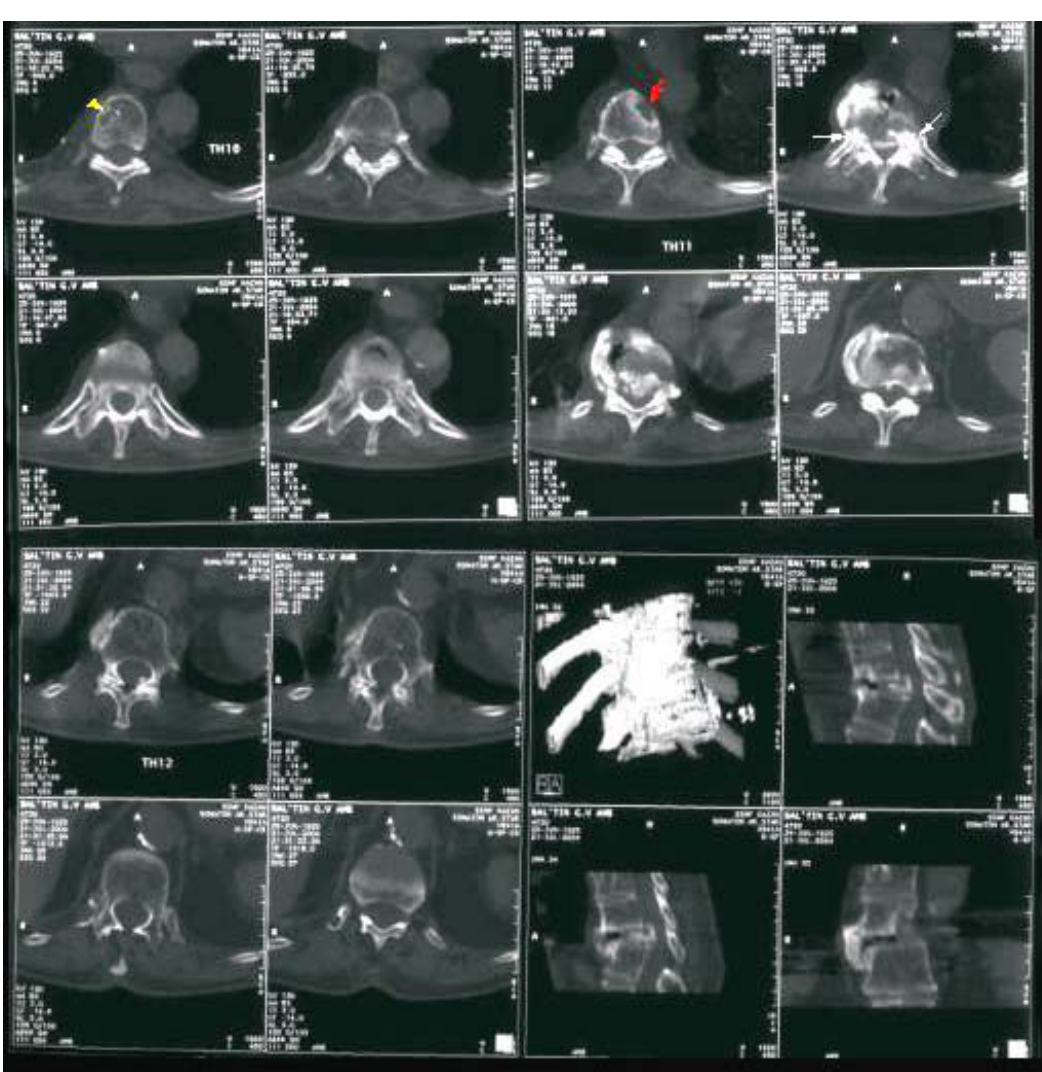
FIGURE 2 . MRIs of patient with backbone metastases (after treatment with bacteria). There is progressive spinal deformity: collapse of the anterior part of Th.XI. vertebral body is complete with more prominent wedge-shaped deformity. Posterior sclerotic bony elements shifting towards the canal cause significant stenosis (at least 50% in AP direction). Remarkable osteophytic appositions have developed on the right lateral aspect of Th.X.–XI. intervertebral spaces. There is marked progression of sclerotic degenerative changes in the facet joints as well. There is sclerosis in the vertebral arches instead of the formerly observed lytic areas. No evidence of soft-tissue mass. The lytic area affecting the left anterior aspect of Th.X. vertebral body became demarcated by irregular slerotic margin. The lesion in the Th.IX. vertebral body is unchanged. Compression fracture of Th.XI. vertebral body was probably caused by lytic bone pathology, which seemed to affect Th.X. vertebral body as well. From the available data, the nature and dignity of this process cannot be determined with confidence; both malignant neoplasia (metastasis) and benign tumors/tumor-like lesions may be taken into consideration. The follow-up, however, reveals progression only in the secondary deformity and the accompanying degenerative changes with consolidation and demarcation of the lytic components. This could be explained by an effect of successful antineoplastic, bacterial-based treatment of a malignant tumor. The probability of malignancy would set lower. The lesion in the Th.IX vertebral body had slightly different imaging characteristics that have not changed in the follow-up period, hence it may represent benign pathology different from the one affecting Th.X–XI. segments. The most striking finding of the follow-up scan is the evolution of significant bony spinal canal stenosis. Sclerosis in place of former lytic areas in Th.XI. vertebra: white arrows; unchanged lytic lesion in Th.IX. vertebral body with sclerotic margin: short yellow arrow; lesion in Th.X. vertebral body at its lower rim with sclerotic margins: red arrow.